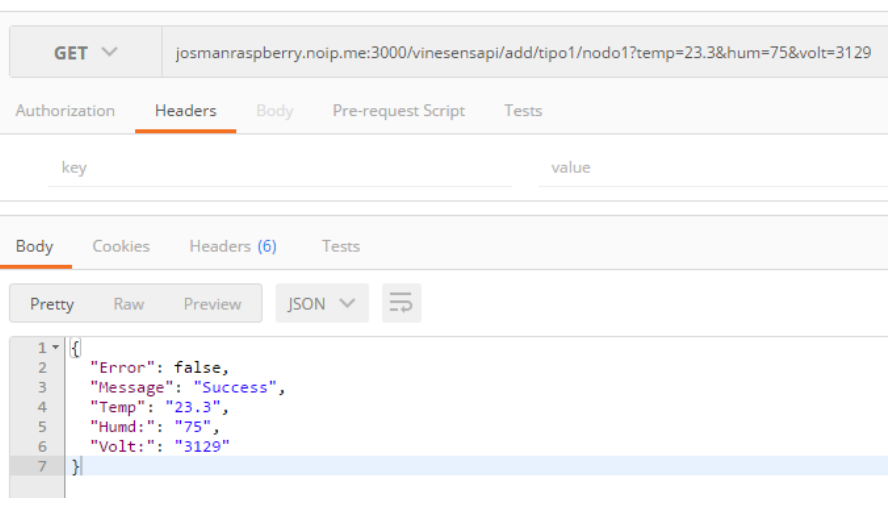
Figure 7. Example of the execution of an API store request.